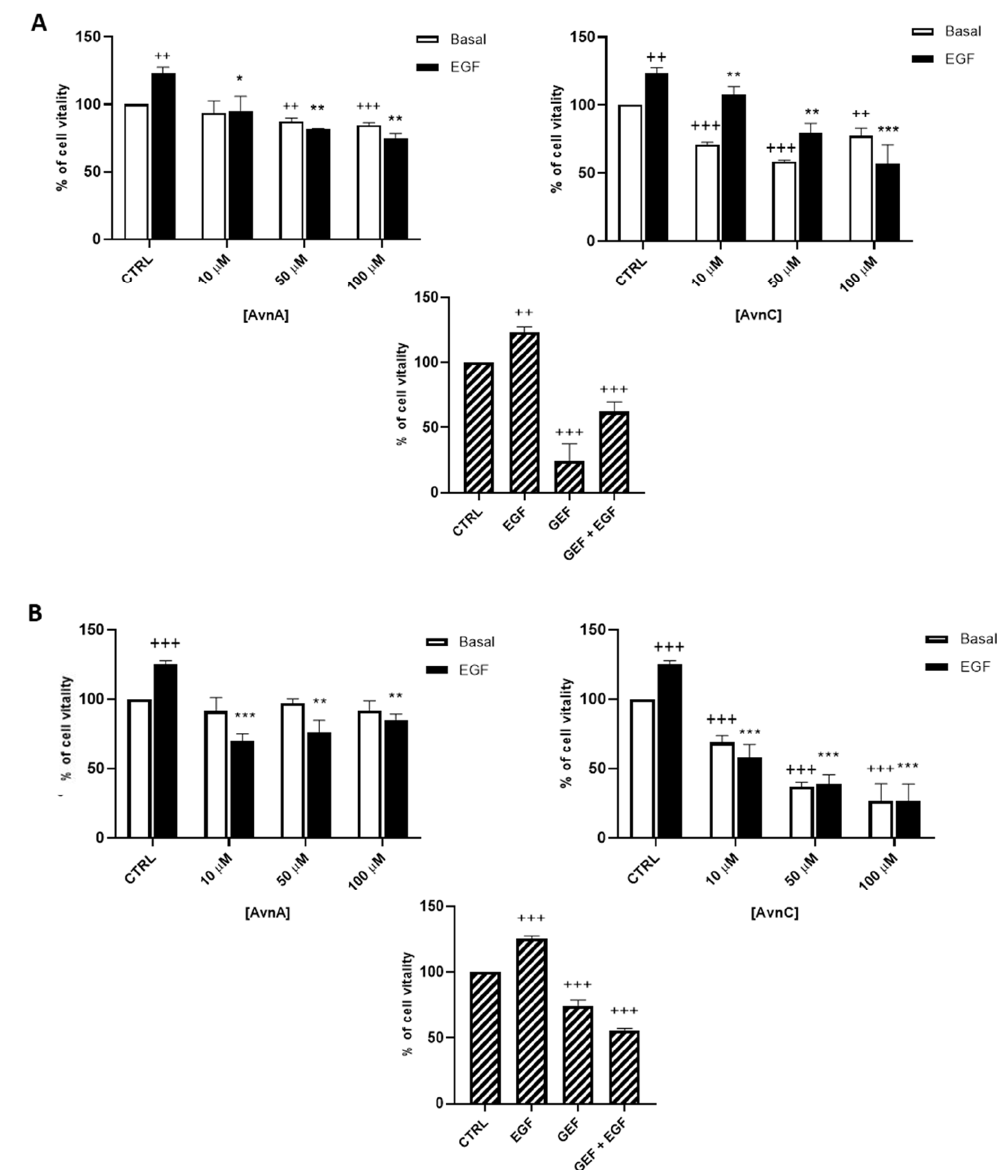
Figure 1. Effect of natural Avns on lung cancer cell vitality. A549 ( A ) and H1299 ( B ) vitality was evaluated by the MTT assay. Cells were exposed to EGF in presence of increasing concentrations of Avns (10, 50, and 100 μ M) for three days. Data are expressed as % over basal control and are representative of three independent experiments run in triplicate. Statistical analysis: +++ p < 0.001 and ++ p < 0.01 vs CTRL; *** p < 0.001; ** p < 0.01 and * p < 0.05 vs. EGF.